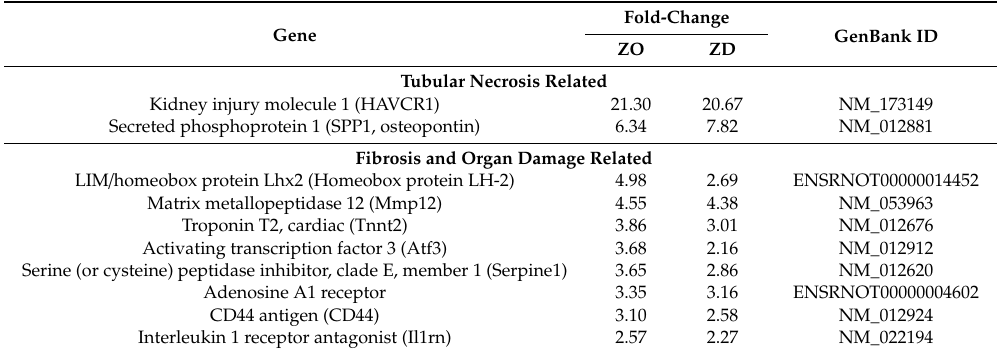
Table 2. Genes that play roles in fibrosis and kidney injury whose expression in the kidney was similarly altered in Zucker obese (ZO) and Zucker diabetic (ZD) rats.